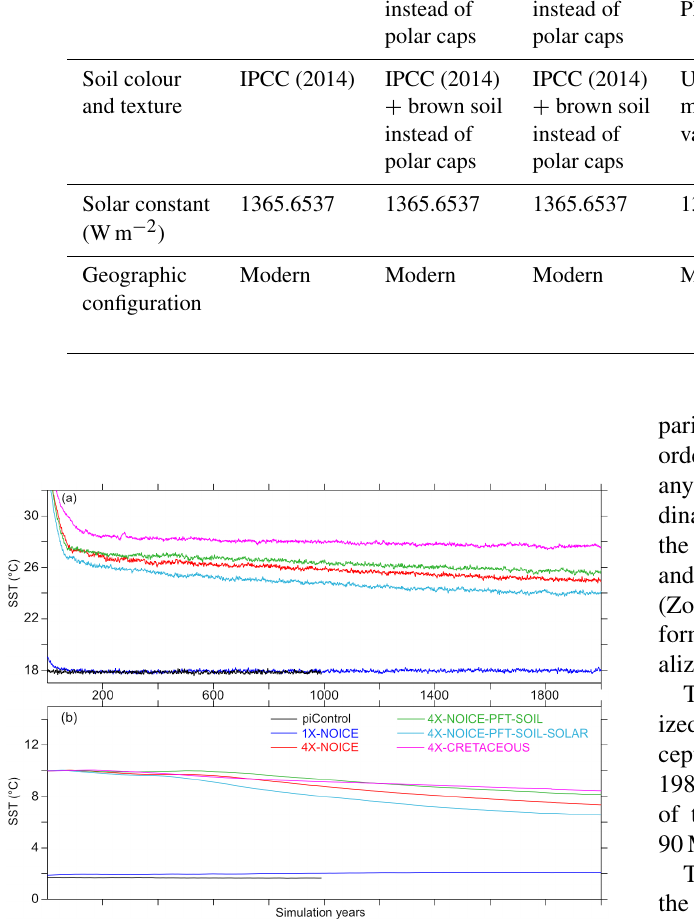
Figure 1. Time series for mean annual oceanic temperatures. (a) Sea-surface temperature and (b) deep-ocean (2500m) tempera- ture. The piControl and 1X-NOICE simulations are perfectly equi- librated. The 4X simulations still have a small linear drift, around 0.1 ◦ C per century or less: 0.07, 0.08, 0.05 and 0.01 ◦ C per century during the last 500 years for SST of 4XNOICE, 4X-NOICE-PFT- SOIL, 4X-NOICE-PFT-SOIL-SOLAR and 4X-CRETACEOUS re- spectively; 0.11, 0.08, 0.07 and 0.06 ◦ C per century during the last 500 years, for deep ocean of 4X-NOICE, 4X-NOICE-PFT- SOIL, 4X-NOICE-PFT-SOILSOLAR and 4X-CRETACEOUS re-